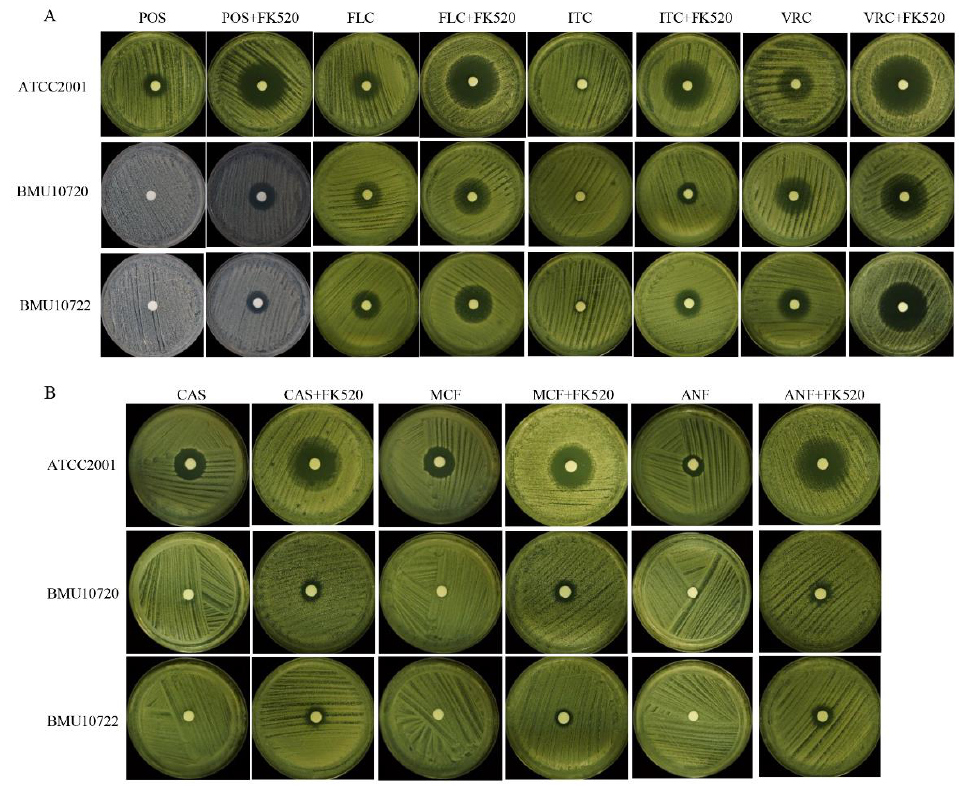
Figure 3. Synergic activity of FK520 with triazoles, echinocandins, and cell wall-perturbing agents. POS, posaconazole; FLC, fluconazole; ITC, itraconazole; VRC, voriconazole; CAS, caspofungin; MCF, micafungin; ANF, anidulafungin. ( A ) Disk diffusion of FK520 with triazoles: POS (10 μg), FLC (80 μg), ITC (80 μg), VRC (10 μg), without or with FK520 (20 μg). The inhibition zones of POS, FLC, ITC, and VRC combined with FK520 in ATCC2001, BMU10720, and BMU10722 were significantly larger than those of triazoles used alone. ( B ) Disk diffusion of FK520 with echinocandins: CAS (10 μg), MCF (10 μg), ANF (10 μg), without or with FK520 (20 μg). The inhibition zones of CAS, MCF, and ANF combined with FK520 in ATCC2001, BMU10720, and BMU10722 were significantly larger than those of echinocandins used alone.